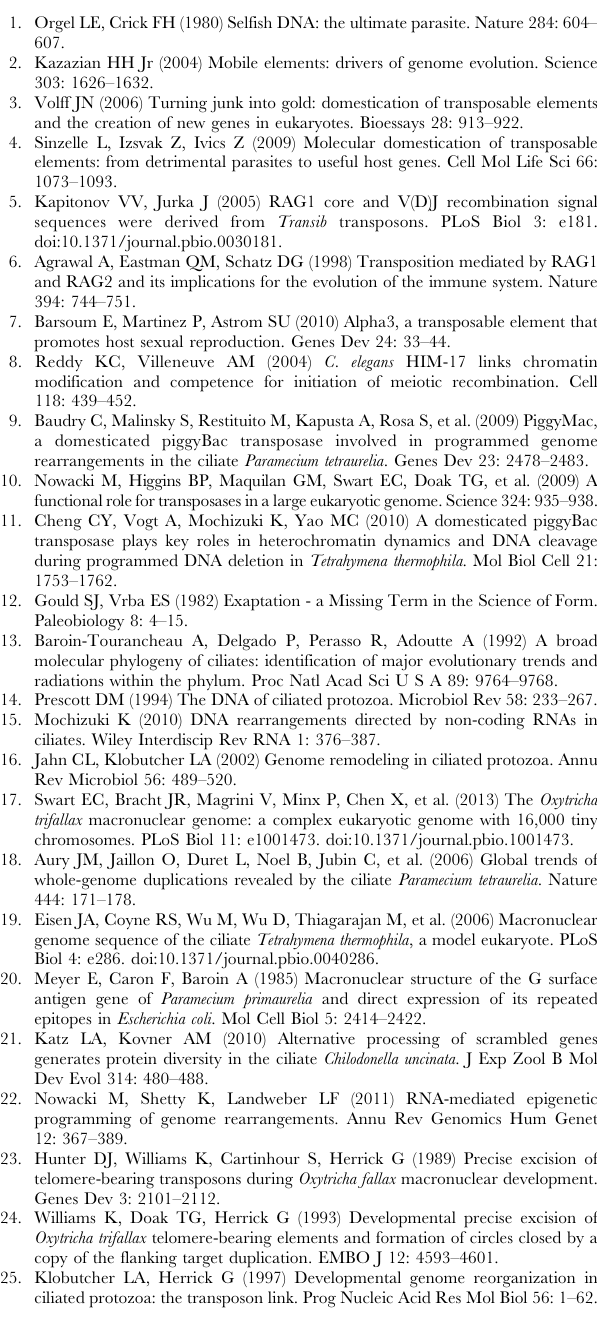
Figure 4. The alignment was produced using the MUltiple Sequence Comparison by Log-Expectation (MUSCLE) web server (http://www.ebi.ac.uk/Tools/msa/muscle/). The masking se- quence indicates alignment positions used for phylogenetic